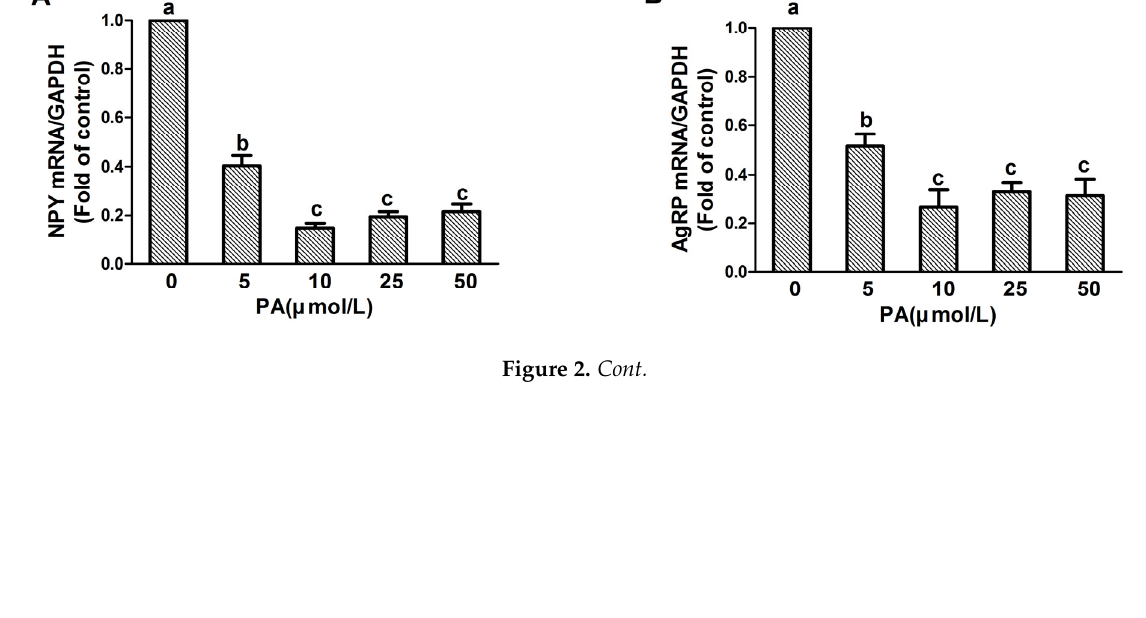
Figure 2. Dose ‐ dependent effect of PA on NPY, AgRP, and POMC expression in N1E ‐ 115 cells. Quantitative real ‐ time PCR amplification of NPY, AgRP, and POMC performed with RNA extracted from N1E ‐ 115 cells following treatment with differing concentrations of PA for 20 min ( A – C ), respectively. Quantified mRNA levels were normalized to GAPDH and presented relative to 0 μ mol/L PA for 20 min. Data are expressed as means ± SEM of three different experiments. Groups sharing different letters above the bars indicate statistically significant differences ( p < 0.05), while those denoted by the same letters are insignificant ( A – C ). PA: palmitic acid group. 3.3. CD36 Is Involved in the PA ‐ Dependent Regulation of NPY and AgRP Gene Expression The role CD36 plays in the effect of PA on NPY and AgRP was examined. N1E ‐ 115 cells were treated with varying concentrations of PA for 20 min or with 10 μ mol/L PA for different time periods. As shown in Figure 3A, 10 min after the cells were treated with 10 μ mol/L PA, the CD36 mRNA level nearly doubled, and then continued to increase until it reached the maximum level at 20 min, which was maintained for the duration of the experiment (F value = 7.192, p < 0.05). Similar to what we observed for NPY and AgRP expression, the 10 μ mol/L dose displayed the strongest effect on CD36 expression (F value = 11.107, p < 0.05) (Figure 3B). The CD36 protein level was increased when the cell was treated with 10 μ mol/L PA for 20 min (F value = 45.464, p < 0.05) (Figure 3C).